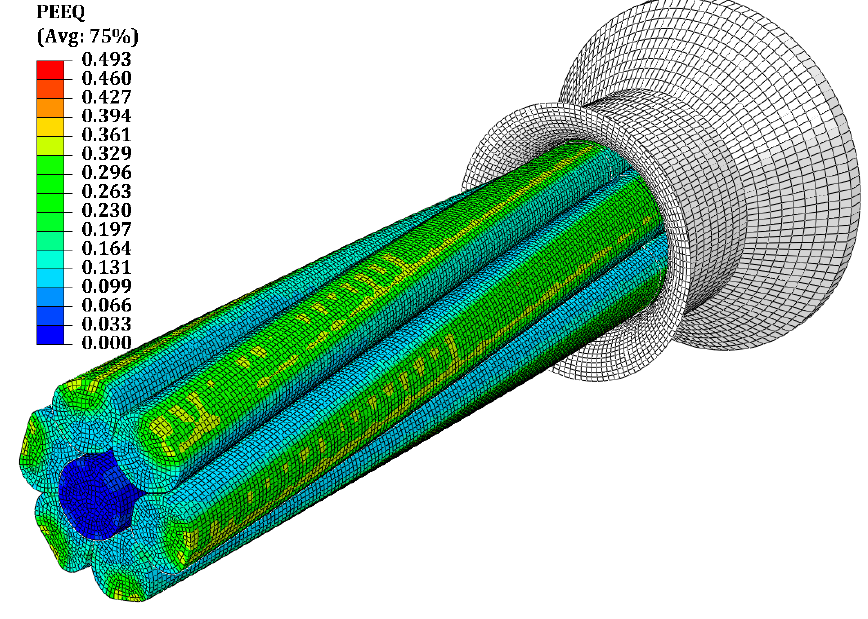
Figure 11. Simulation of the compacting process: ( a ) Equivalent plastic deformation; ( b ) conductor cross-section before and after the stranding and compacting process.